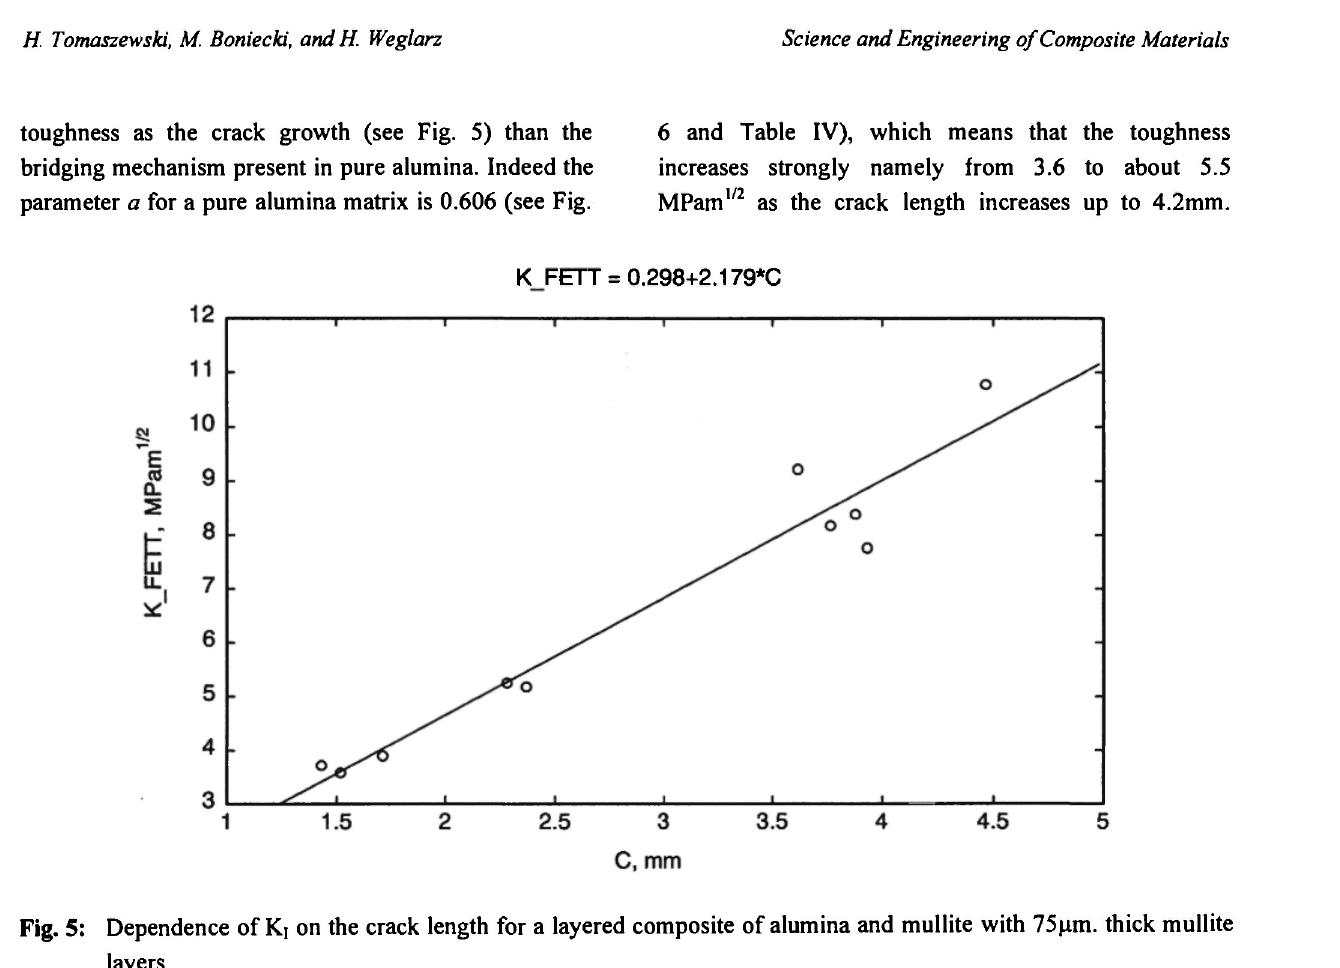
Fig. 5: Dependence of Κι on the crack length for a layered composite of alumina and mullite with 75μπι. thick mullite layers.